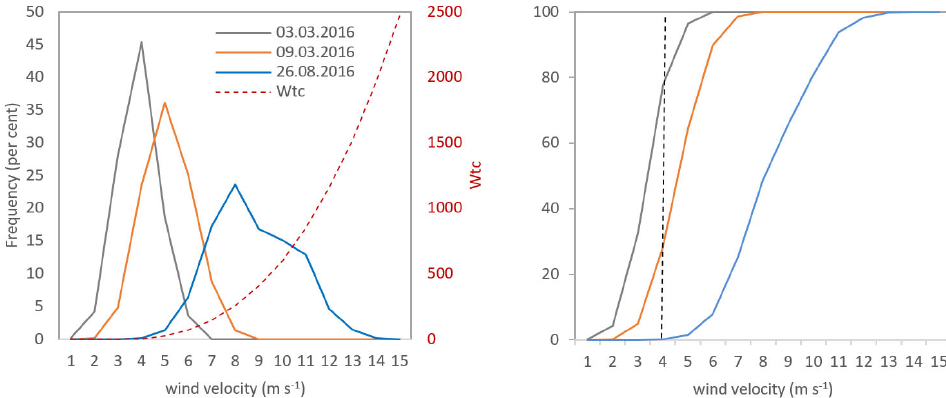
Figure 3. Frequencies of wind velocities of the three measuring campaigns; left: absolute values, W tc for a threshold of 4 m s − 1 ; right: summarized values .